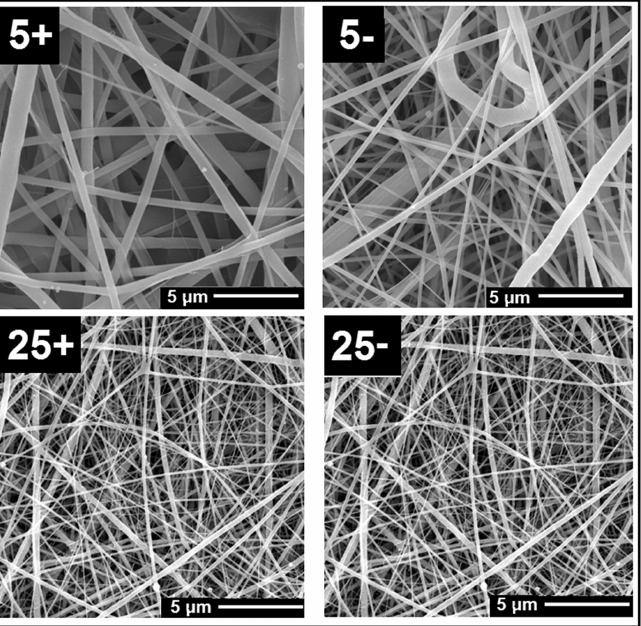
Figure 12. FESEM images of PCL/CHT samples formed on the spinning nozzle with negative and positive charge polarity. Reprinted with permission from ref.